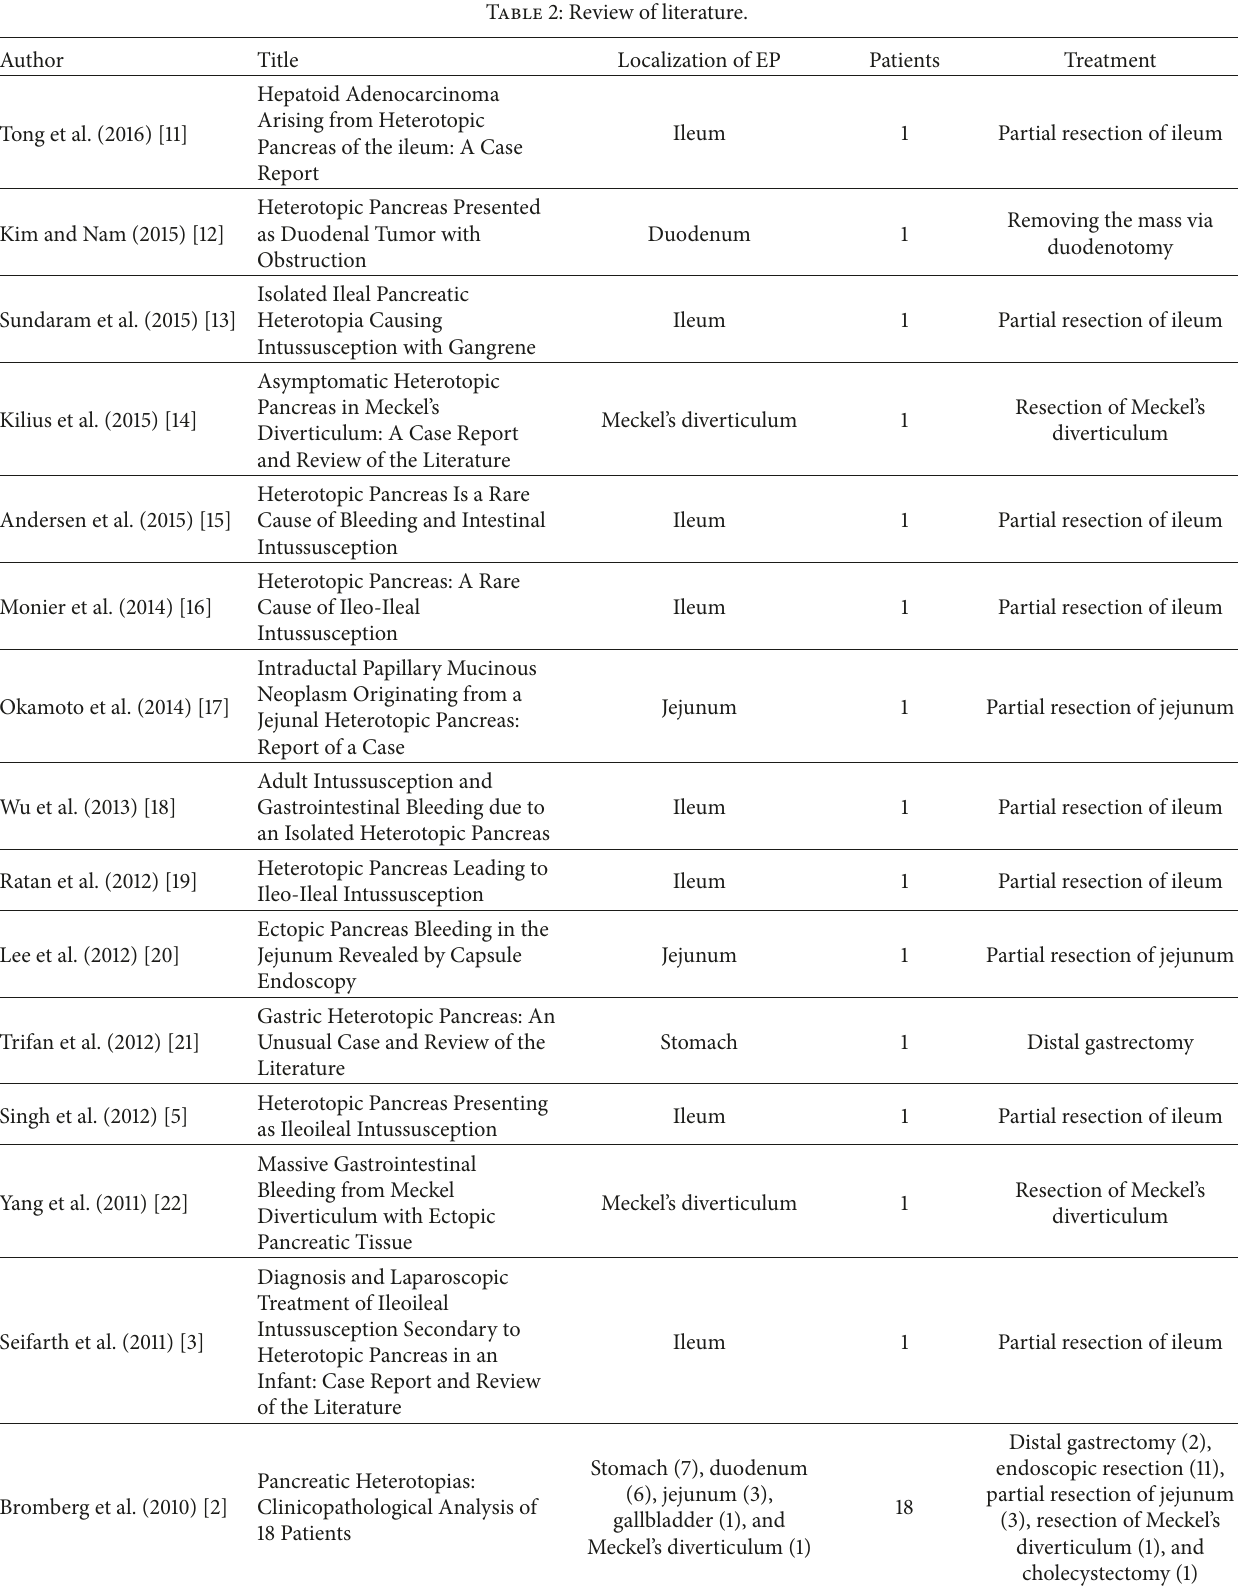
Table 2: Review of